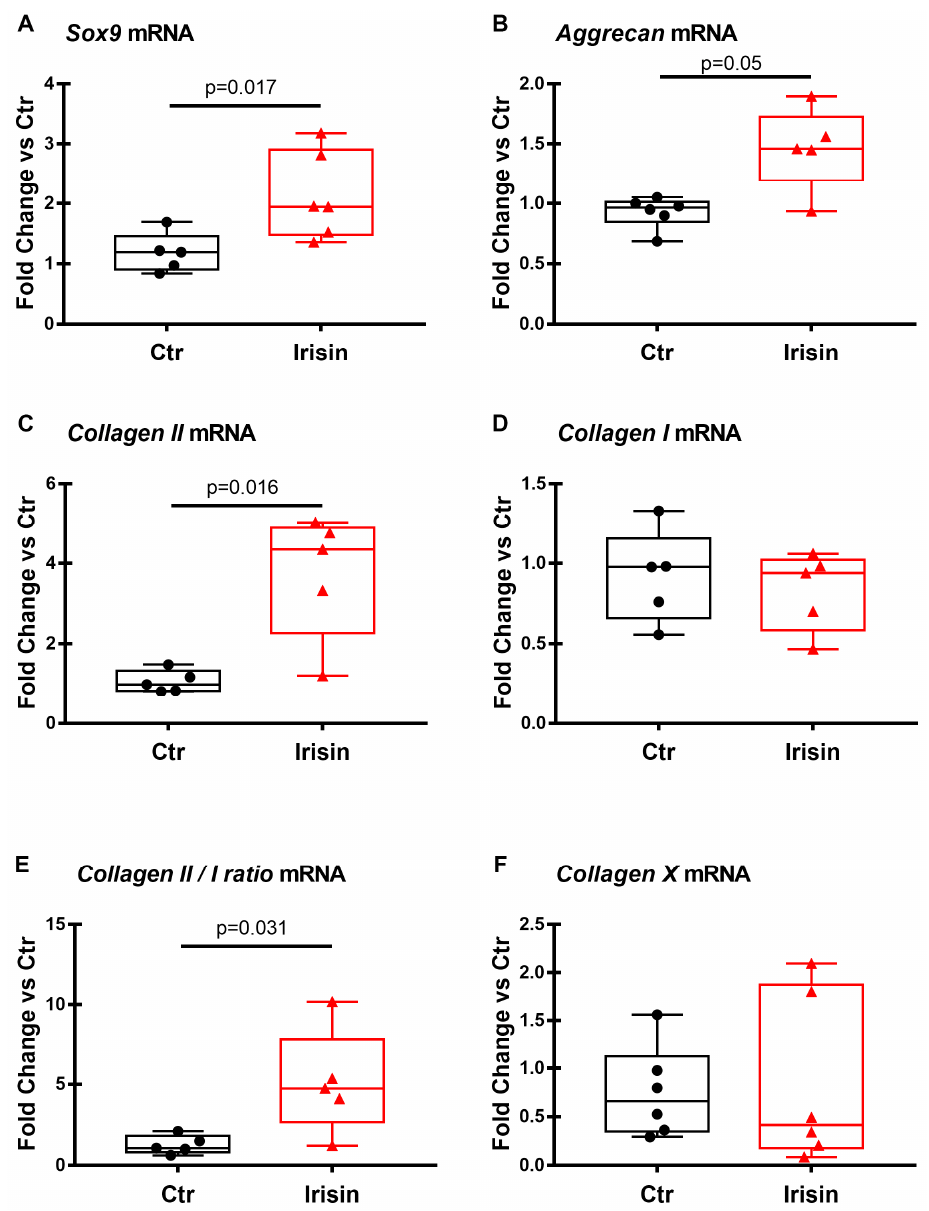
Figure 3. Effects of Irisin on the mRNA expression of chondrogenic markers. mRNA expression levels of chondrogenic marker genes Sox-9 ( A ), Aggrecan ( B ), Collagen II ( C ), Collagen I ( D ), and Collagen X ( F ) were analyzed (qPCR) after 21 days of stimulation with Irisin. The graphs show that the treatment significantly increased the expression of Sox -9, Aggrecan, Collagen II, and Collagen II / I ratio ( E ). Expression was normalized to the average of β -actin and B2M levels for each reaction. Data are shown as box-and-whisker plots with median and interquartile ranges, from max to min. A Mann–Whitney test was used to compare groups. p -values as